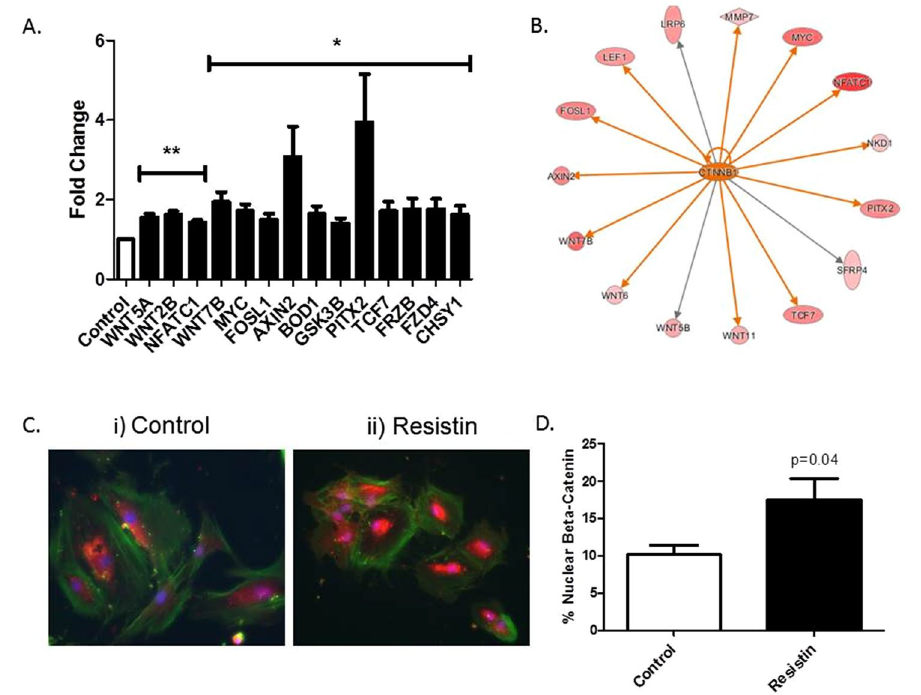
Figure 3. Analysis of the Wnt signalling pathway in human primary osteoblasts following resistin stimulation. ( A ) Canonical Wnt signalling pathway gene expression following resistin stimulation. Primary human osteoblasts cells were stimulated with 500 ng/ml recombinant resistin for 24 hours prior to gene analysis, with 14 genes shown to be up-regulated ( ** p < 0.01, * p < 0.05). ( B ) IPA analysis of Wnt genes differentially expressed > 1.4 fold change with resistin stimulation and the predicted increase in β -catenin activity and expression. Orange arrows = predicted activation, grey arrows = effect not predicted. ( C ) Representative images of nuclear translocation of β -catenin in human osteoblasts following i) media only ii) 30 min of resistin stimulation (500 ng/ml). Green = α -Actin, Blue = Hoechst, and Red = β -Catenin (n = 3). ( D ) Quantification of nuclear translocation of β -catenin in human primary osteoblasts using Image J software. Percentage nuclear β -catenin refers to the subset within the area of hoechst staining compared to the whole cell and is an average of 6 images from 3 OA patient cell lines (n =